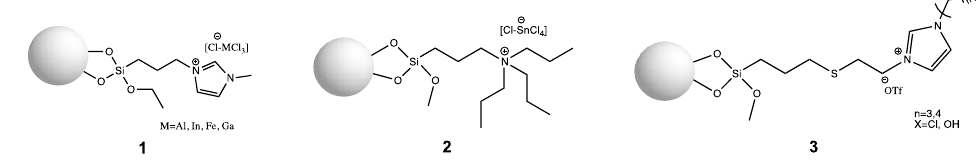
Figure 6. Structures of Lewis type silica-based SILLP materials. Table 1. Lewis type silica-based SILLP in organic catalysis.